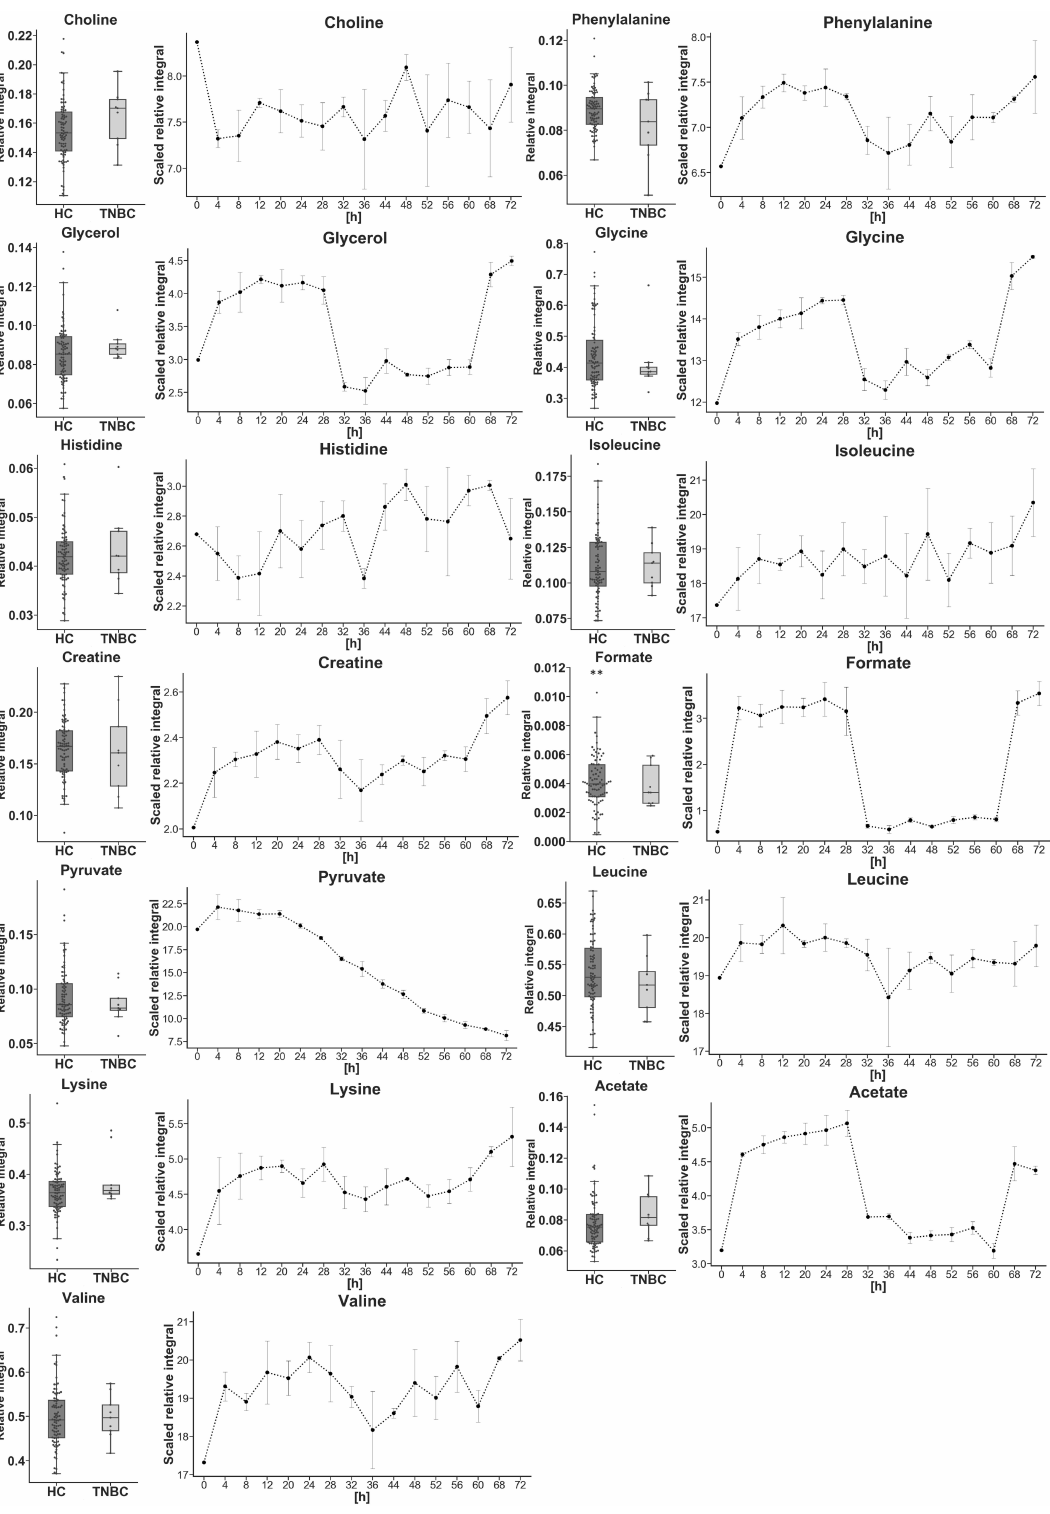
Figure 5. Identified non-statistically important metabolites HC vs. TNBC in serum (box plots) with the matching metabolites’ resonance signals from the cell culture experiments. The data points in line plots are the mean values of triplicates for each time interval with standard deviation error bars . In the boxplots: whiskers = 1.5 × IQR; lines = average; boxes = interquartile range Q1-Q3; ** extreme outlying observation beyond the plot